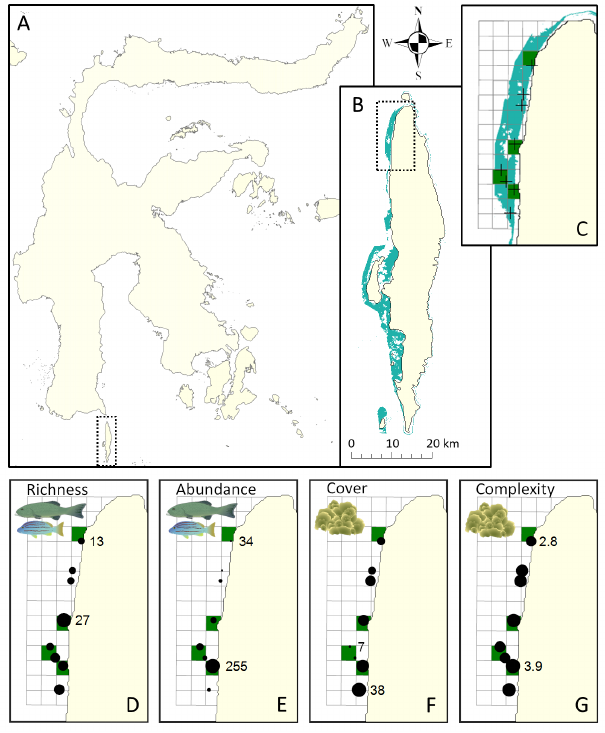
Fig. 1. Maps of the study area, field survey sites, and field survey outcomes. (A) Sulawesi, Indonesia, highlighting Selayar Island in the dashed box. (B) Selayar Island and surrounding coral reefs, highlighting the study area in western Bungaiya in the dashed box. (C) Coral reef habitat in western Bungaiya. Subplots in the lower panel show observed fishery species richness (D), fishery species abundance (E), live coral cover (F), and reef habitat complexity (G). Green cells = proposed reserve locations. Black symbols = field survey sites. Circle sizes scale to magnitude, with numbers highlighting minima and maxima next to respective